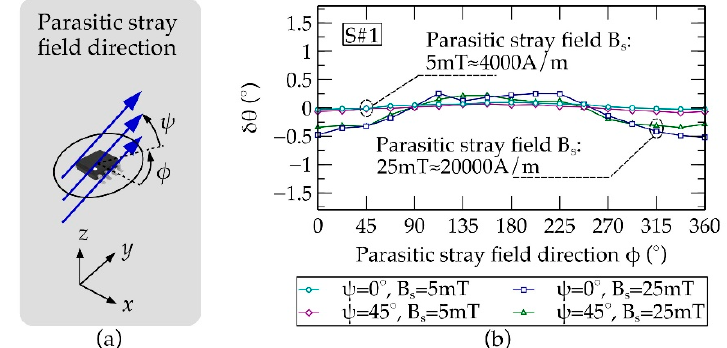
Figure 5. Impact of the applied parasitic stray field on the measured angle. ( a ) Sample S#1 was exposed to stray fields of 4000 A/m and 20,000 A/m from various directions φ and ψ . ( b ) The observed typical changes in the measured angle δ θ were below 0.1° and 0.5°,